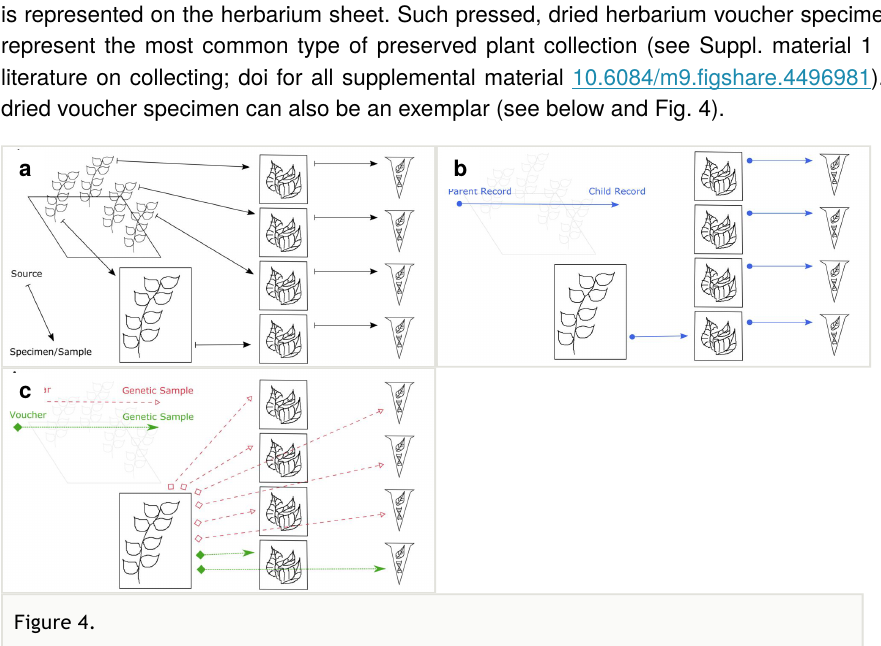
The physical relationships among samples (doi for all fi gures 10.6084/m9. fi gshare.4496978): a : One voucher specimen and three genetic (tissue) samples are taken from an individual